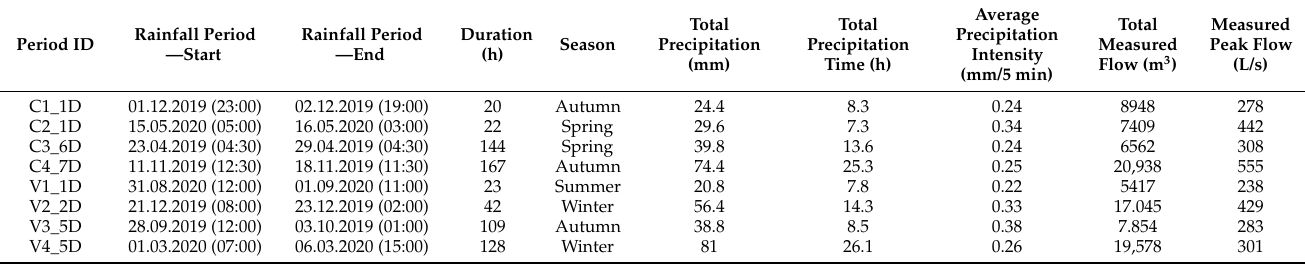
Table 1. Characteristics of the selected rainfall periods used for calibration and